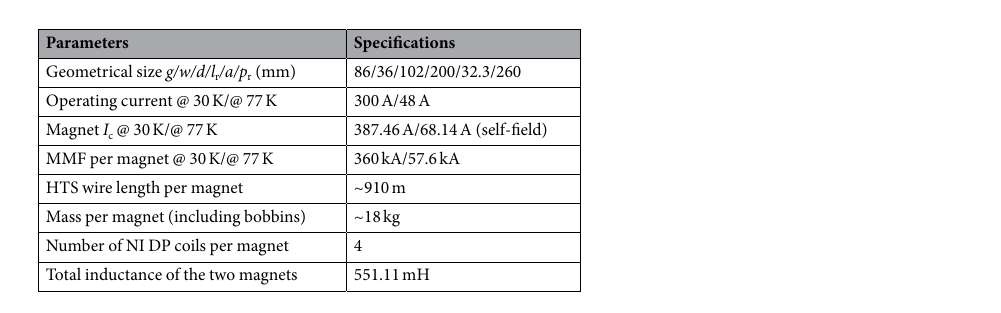
Table 1. Summary of the design optimization results at 30 K and 77